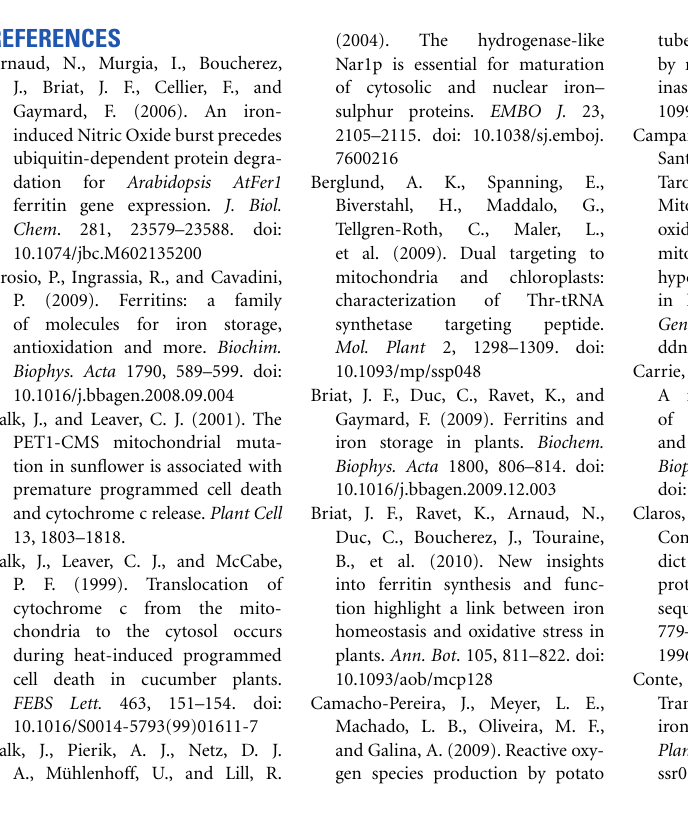
Figure S1 | Predicted coding sequence for XP004163525protein. Figure S2 | Predicted coding sequence for